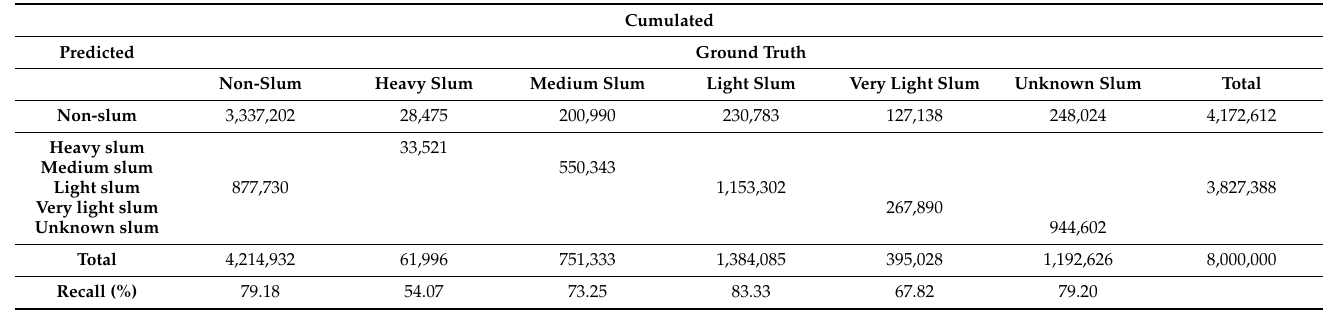
Table 4. The Modified FCN-DK6_2 cumulated confusion matrix, which includes various slum categories and non-slum (other).